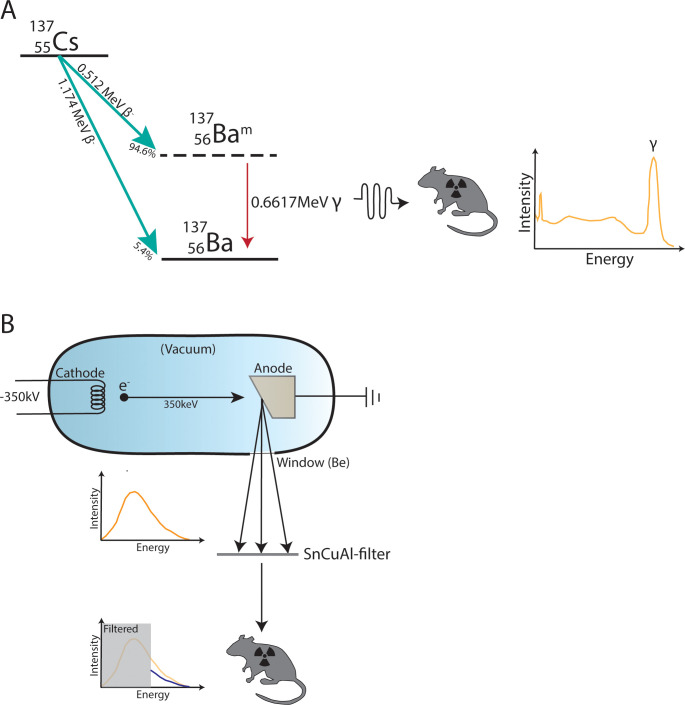
Schematic illustration of Cesium-137 (Cs-137) gamma versus X-ray irradiation.A) Cs-137 decays by β-emission mainly (94.6%) to the metastable nuclear isomer of Barium-137 (Ba-137), which then decays to the stable form by emitting γ-irradiation. About 5.4% of the Cs-137 will directly decay to the stable form of Ba-137. The β-irradiation does not affect the mouse since it cannot pass through the plastic container holding it, while the γ-irradiation will. B) X-rays are produced using an X-ray tube where a tungsten filament is heated and a high electrical tension is applied, rendering it a cathode which accelerates electrons (e-) at high speed towards a grounded target acting as anode. This creates a continuous spectrum of energies. The low energy photons are filtered out using a filter composed of tin (Sn), copper (Cu) and aluminum (Al). However, this also lowers the intensity of the radiation accordingly (blue curve). Be; beryllium.